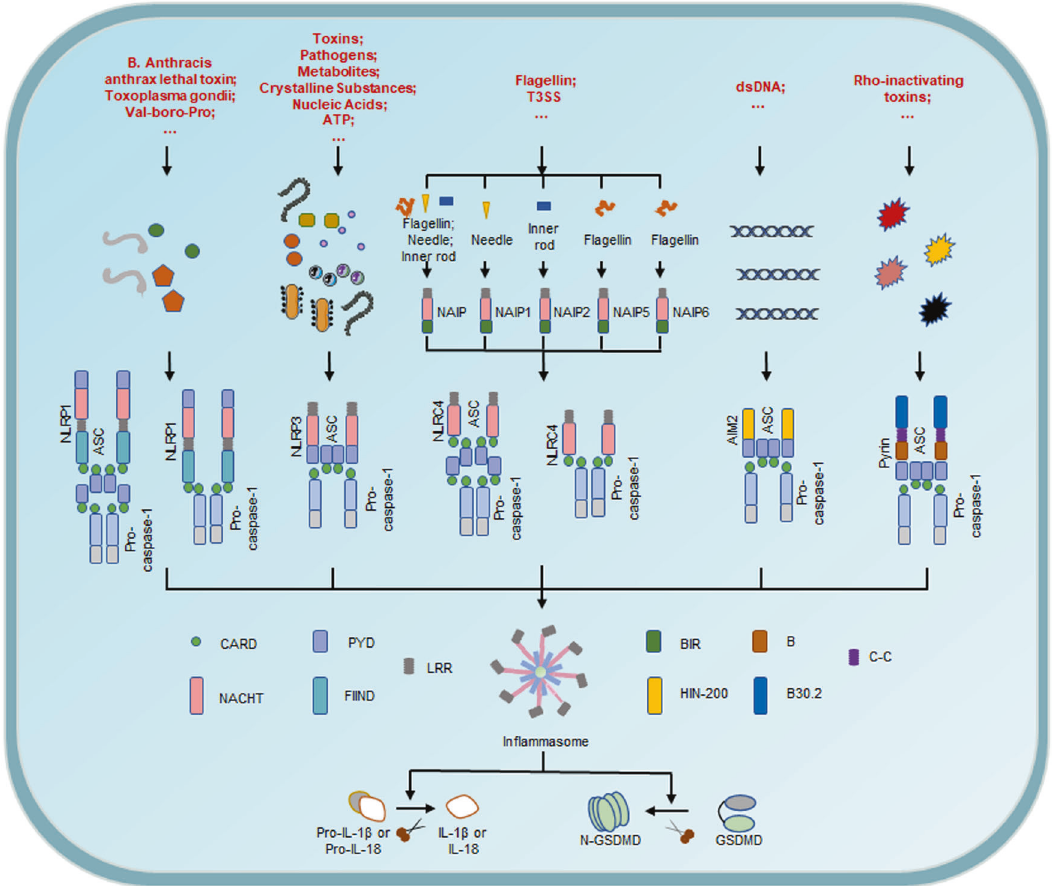
Fig. 3 Multiple assembly mechanisms of canonical in fl ammasomes. The assembly of canonical in fl ammasomes occurs in response to PAMPs and DAMPs. In fl ammasome sensors have interaction with different target ligand. Bacillus anthracis toxin activates the NLRP1 in fl ammasome, and NLRP1 recruits pro-caspase-1 into the complex via ASC or direct contact with CARD-CARD interactions. A variety of PAMPs and DAMPs activate NLRP3 in fl ammasome, which is followed by the recruitment of ASC and pro-caspase-1. Human NAIP senses both bacterial fl agellin and proteins of T3SS components. Mouse NAIP1, NAIP2 and NAIP5/6 sense needle, inner rod, and fl agellin respectively to assemble and activate the NLRC4 in fl ammasome. NLRC4 activates caspase-1 in an ASC-dependent or ASC-independent manner. AIM2 in fl ammasome